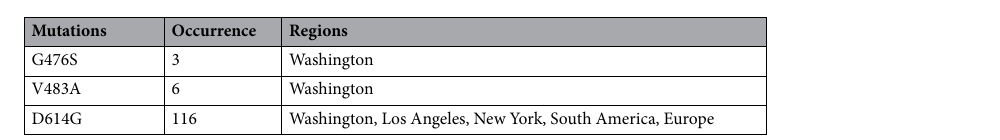
Table 12. Spike protein mutations. Occurrence is the number of isolates that showed the mutation. Region is the origin of the isolates.